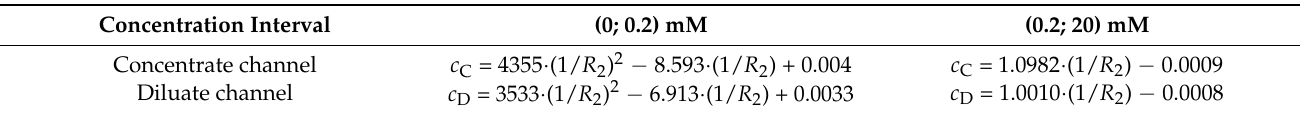
Table 1. The calibration curves used to calculate the KCl concentration solution from the measured magnitude of the impedance. Concentration Interval Concentrate channel